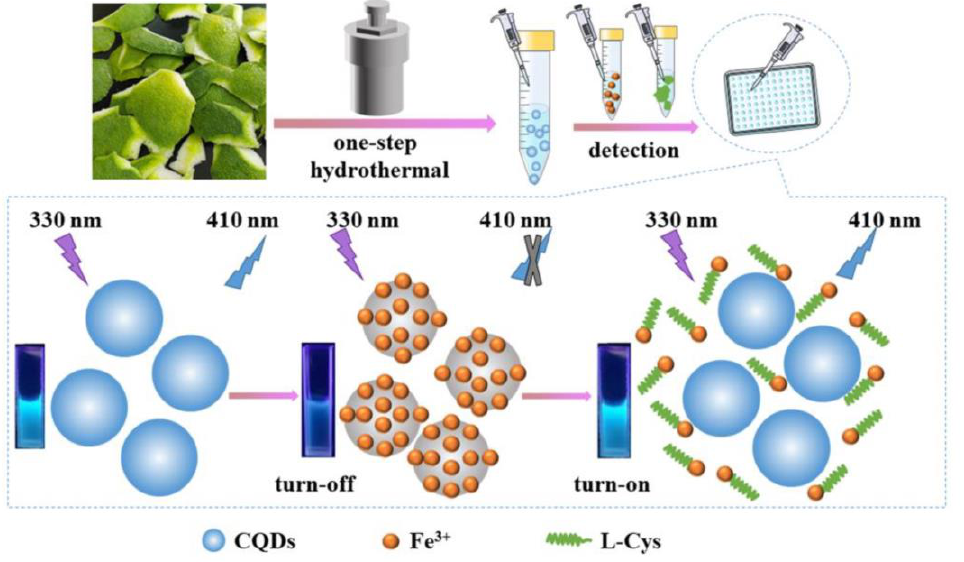
Figure 9. The detection principle for Fe 3+ and L-Cys based on CQDs (reproduced with the permission from Ref. [115]).